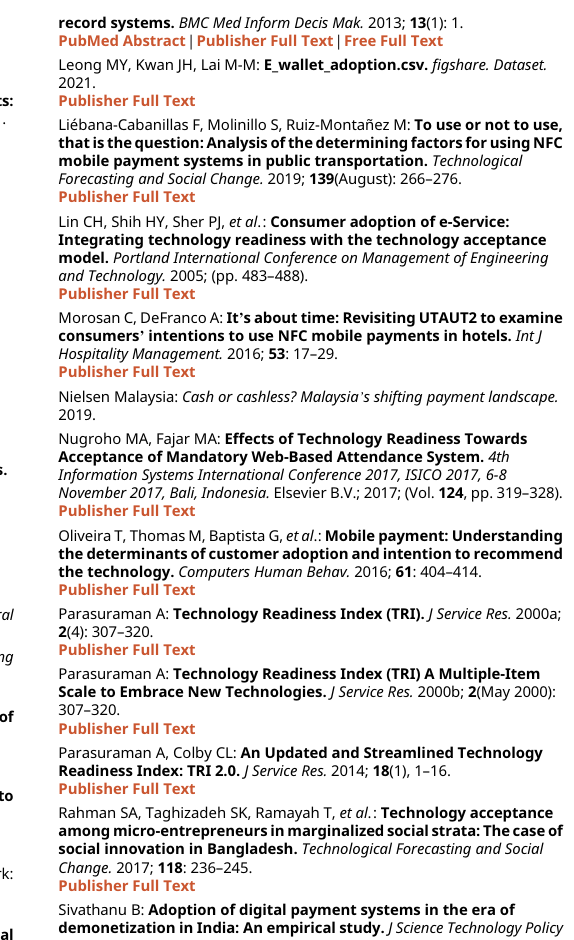
Figshare: E_wallet_adoption.csv, https://doi.org/10.6084/m9.figshare.14871048.v1 (Leong et al.,